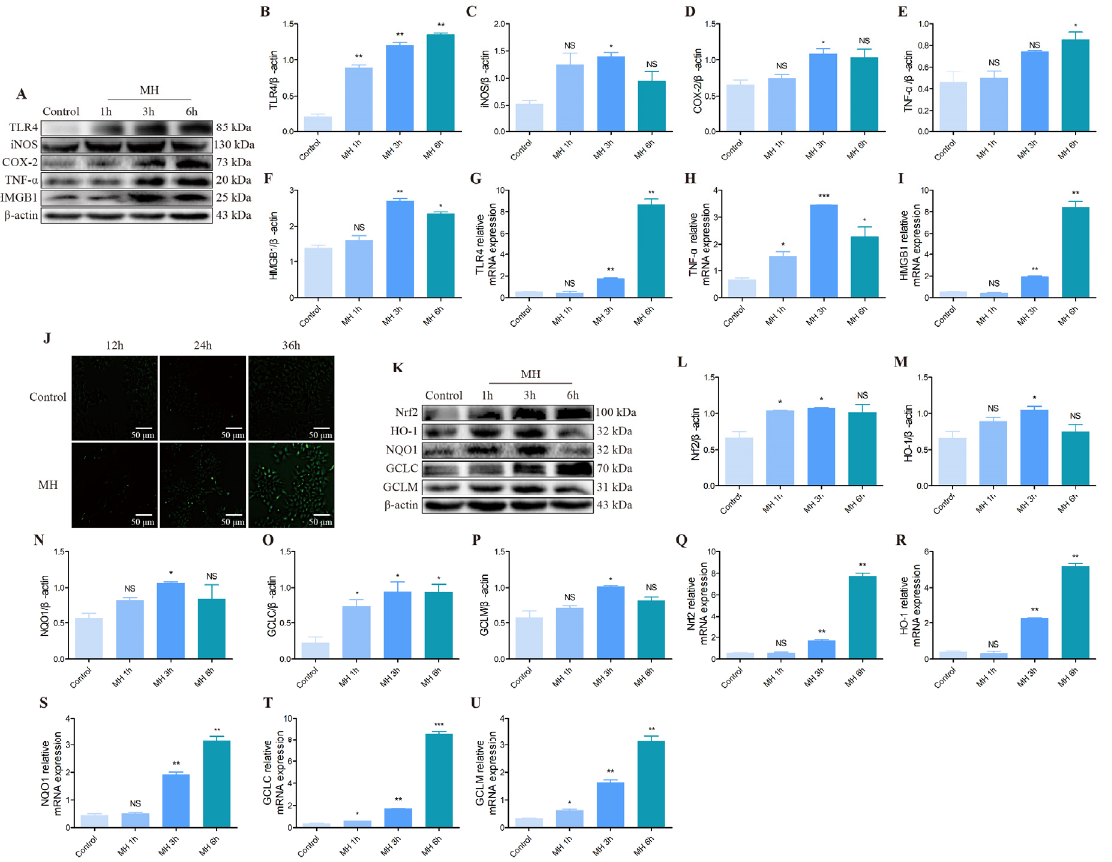
Figure 6. Effect of MH treatment on the expression of inflammatory cytokines and oxidative stress- related indexes in the AML12 cells. ( A ) TLR4, iNOS, COX-2, TNF- α , HMGB1 and β -actin pro- tein levels in each group. ( B – F ) Quantification of expression levels based on expression ratios of TLR4/ β -actin, iNOS/ β -actin, COX-2/ β -actin, TNF- α / β -actin and HMGB1/ β -actin. ( G – I ) The his- tograms of relative mRNA analysis of TLR4/ β -actin, TNF- α / β -actin and HMGB1/ β -actin. ( J ) ROS probe fluorescence staining was used to detect the effect of MH on oxidative stress in AML12 cells. (Scale bar = 50 µ m). ( K ) Nrf2, HO-1, NQO1, GCLC, GCLM and β -actin proteins levels in each group. ( L – P ) Quantification of expression levels based on expression ratios of Nrf2/ β -actin, HO-1/ β -actin, NQO1/ β -actin, GCLC/ β -actin and GCLM/ β -actin. ( Q – U ) The histograms of relative mRNA anal- ysis of Nrf2/ β -actin, HO-1/ β -actin, NQO1/ β -actin, GCLC/ β -actin and GCLM/ β -actin. Data are presented as mean ± standard ( n = 3). NS means not significant, * p < 0.05, ** p < 0.01, *** p <